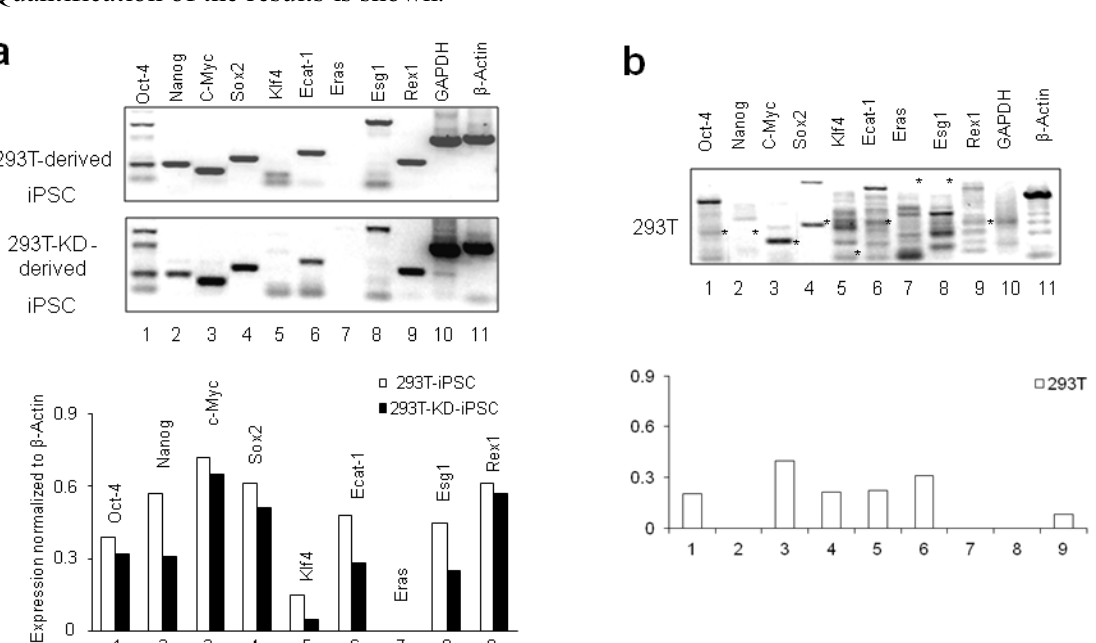
Figure 4. Expression of ES-specific genes by iPSC analyzed by RT- PCR. Expression of ES markers in iPSC derived from 293T and 293T-KD cells ( a ) and in parental 293T cells ( b ). Lane 1, Oct -4; lane 2, Nanog; lane 3, c-Myc; lane 4, Sox 2; lane 5, Klf4; lane 6, Ecat-1; lane 7, Eras; lane 8, Esg 1; lane 9, Rex 1; Lane 10, control GAPDH; lane 11, (cid:70)(cid:82)(cid:81)(cid:87)(cid:85)(cid:82)(cid:79)(cid:3) (cid:533) -Actin. Asterisks show position of the expected PCR products (panel b). Quantification of the results is